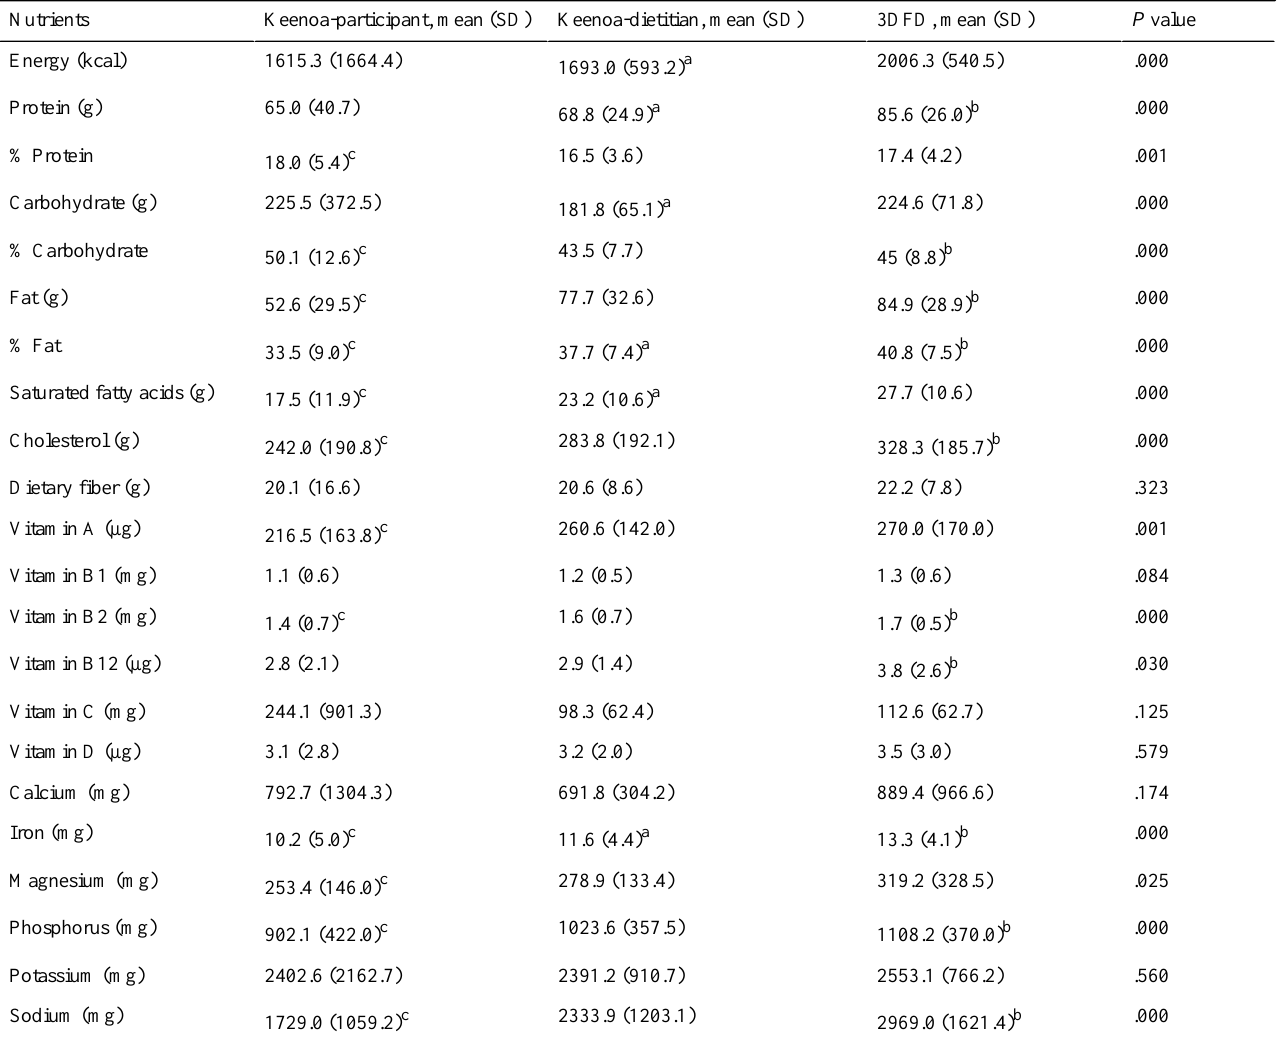
Table 2. Differences between nutrients from Keenoa-participant, Keenoa-dietitian, and 3-day food diary (3DFD; n=72).